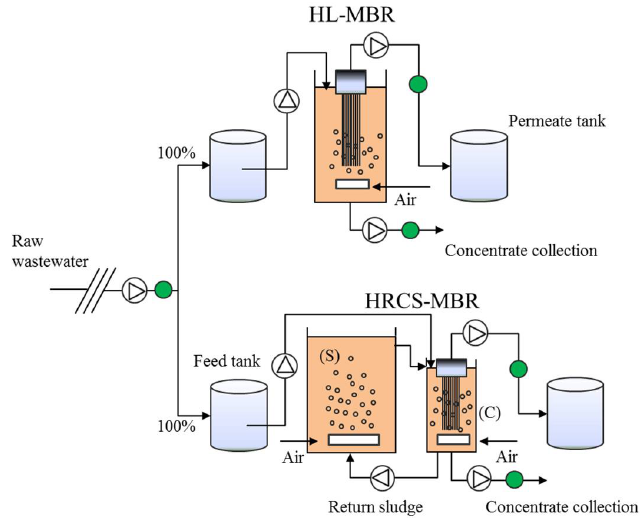
Figure 1. Schematic diagram of the experimental setup for municipal wastewater up-concentration. High-loaded MBR (HL-MBR); High-rate contact stabilization MBR (HRCS-MBR). (C) and (S) indicate contact tank and stabilization tank respectively. indicates sampling points.